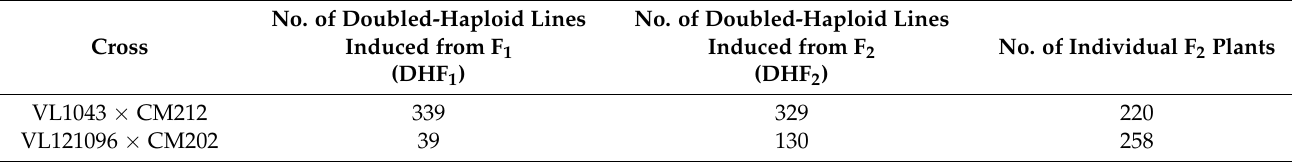
Figure 1. Experimental design used for the development of bi-parentally derived F 2 and DHs induced from F 1 and F 2 plants. Table 1. Number of doubled haploids produced from F 1 and F 2